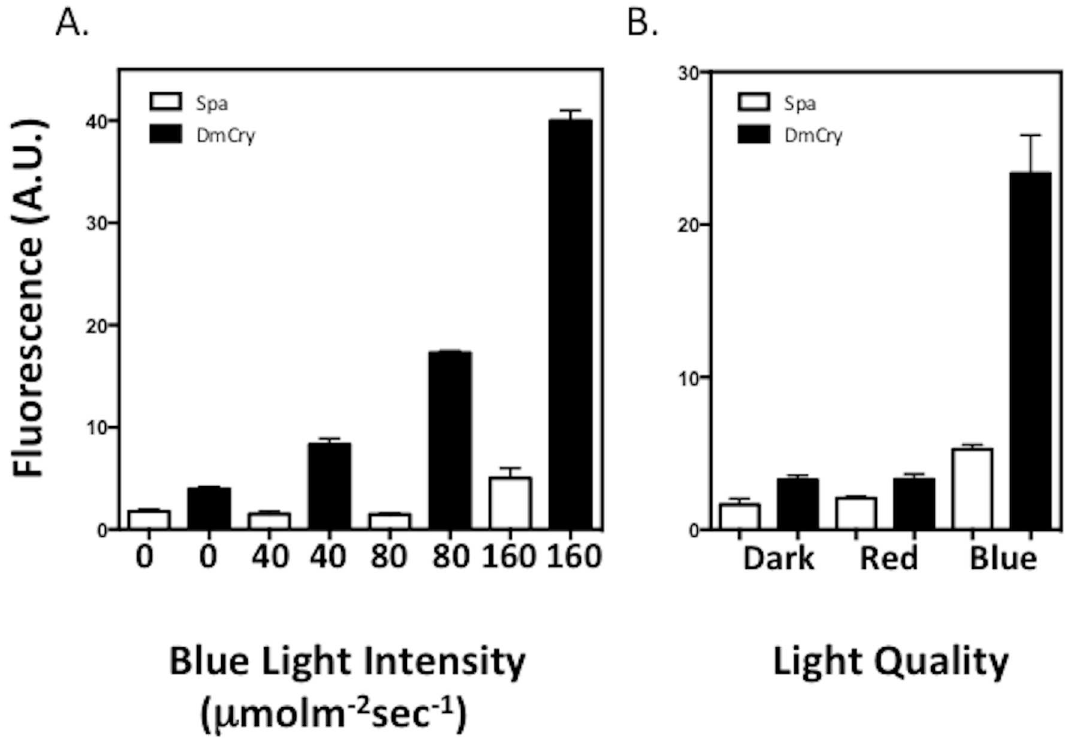
Fig 4. Induction of ROS in insect cell culture expressing DmCry. A. Living insect cell cultures expressingeither DmCry or a SPA1 control construct were treated with the fluorescentsubstrate DCFH-DA and then exposedto the indicatedblue light intensity for 10 min. Subsequently to illumination,DmCry expressingand control cell cultures were harvested, lysed, and evaluatedby fluorescence spectroscopy for the formation of ROS (see Methods). B. Cells exposed to dark, red, or blue light. Error bars represent SD of three